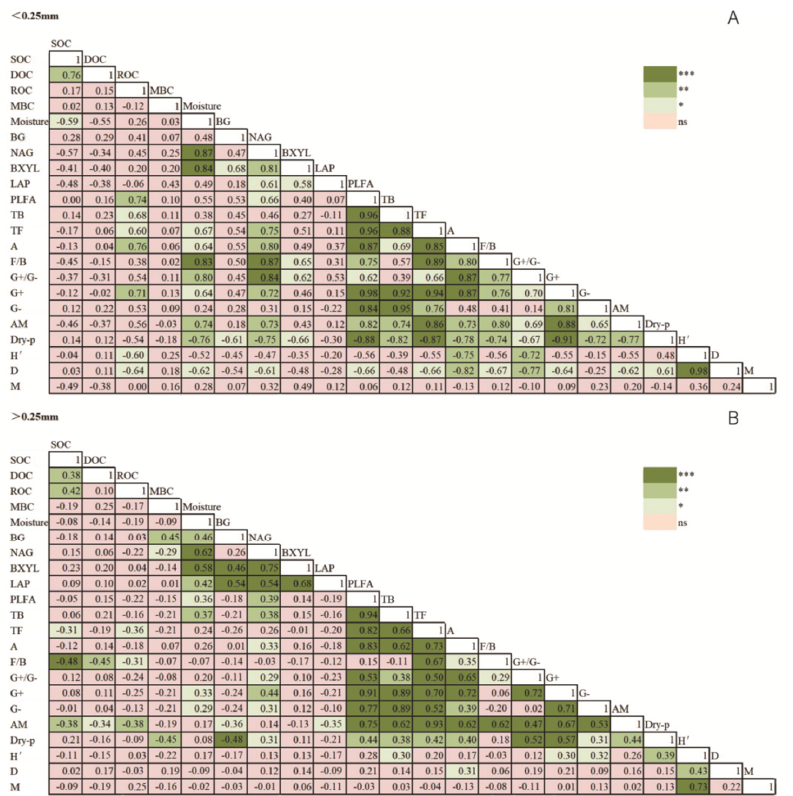
Figure 5. Correlative coefficients between the properties of soil organic C, microbial indices, and enzyme activity in < 0.25 mm ( A ) and > 0.25 mm ( B ) aggregates, respectively. See Table 2 for abbreviations of some soil properties. *: p < 0.05, **: p < 0.01, ***: p < 0.001.